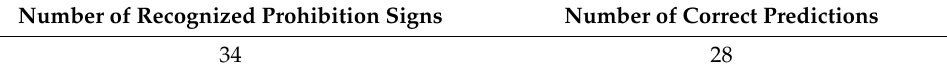
Table 4. Prohibition subclasses analysis.